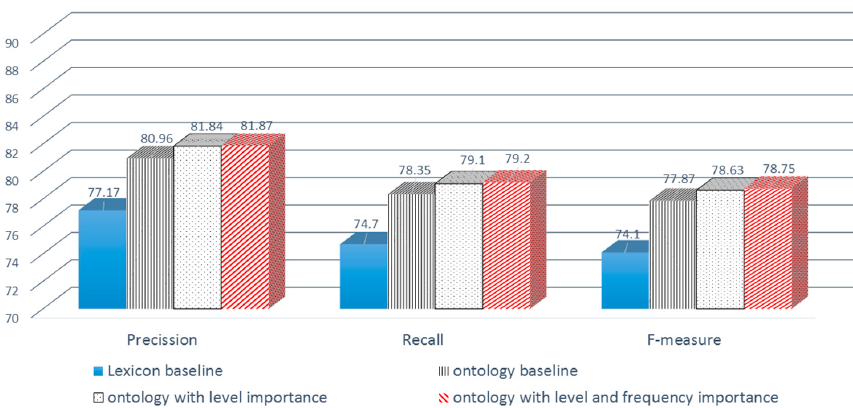
Figure 4. Performance evaluation of ontology for the four implemented schemes.